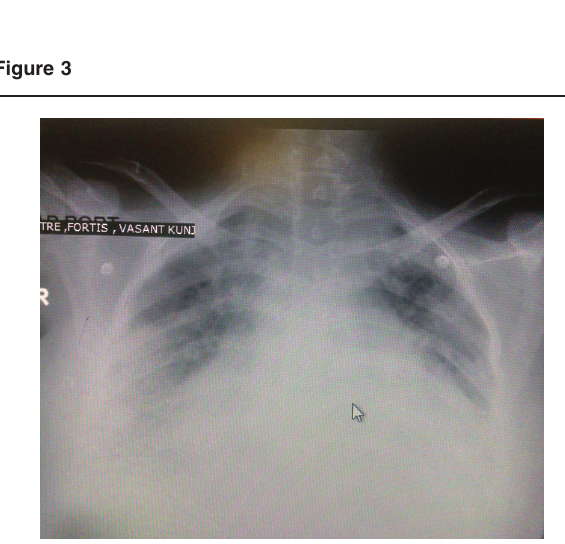
Chest radiograph showing bilateral consolidation with right pleural effusion.